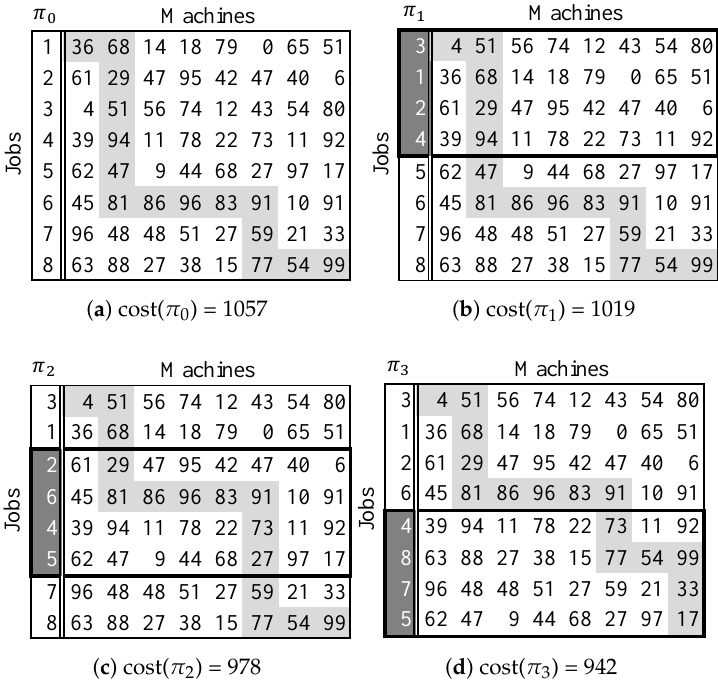
Figure 6. Changing the order of (1,2,3,4,5,6,7,8) to (3,1,2,6,4,8,7,5) in a sample 8 ( × ) 8 problem in 3 steps, with each step optimizing a chunk of size